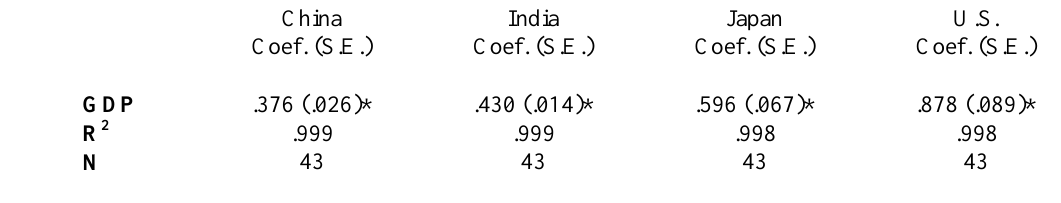
Table 1. Elasticity model of the ecological footprint regressed on GDP using the Prais-Winsten correction for first order auto-correlation for China, India, Japan, and the United States, 1961-2003. China India Coef. (S.E.) Coef. (S.E.) .999 .999 * p <